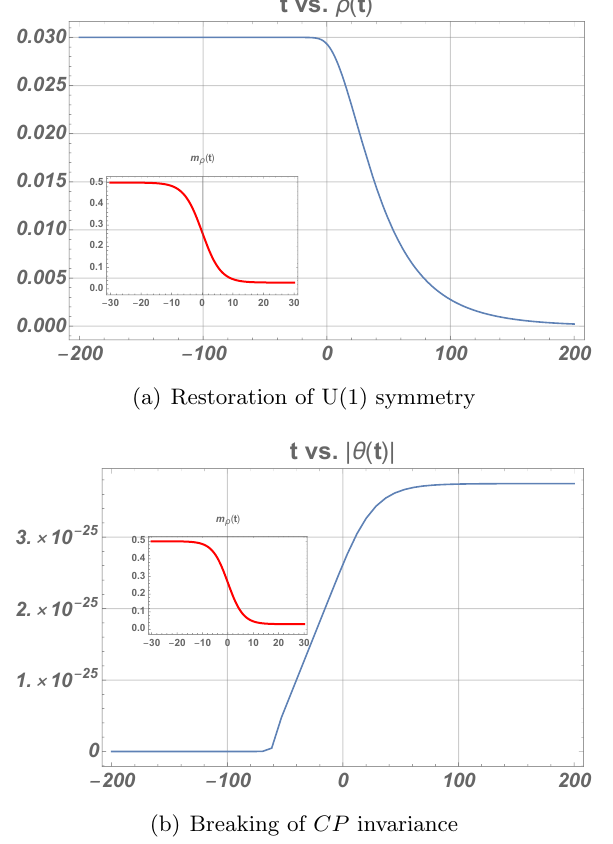
Figure 9 . (a) Plot of (cid:26) ( t ) as a function of time. We have. In (b) we plot (cid:18) ( t ) as a function of